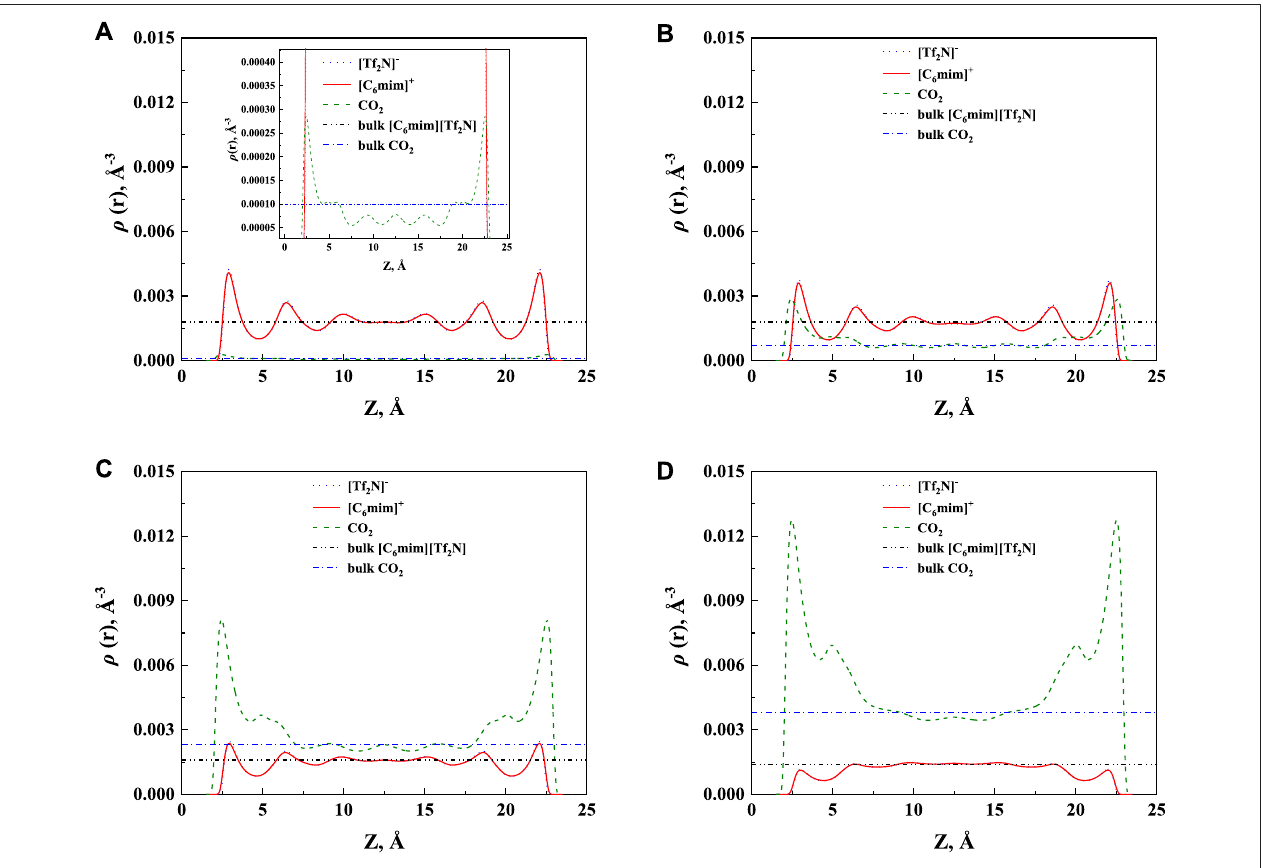
FIGURE 9 | Calculated density pro fi les of [C 6 mim] [Tf 2 N]-CO 2 system con fi ned in 25 Å slit silica pore at 298.15 K and (A) 1 bar, (B) 10 bar, (C) 30 bar, and (D) 50 bar.